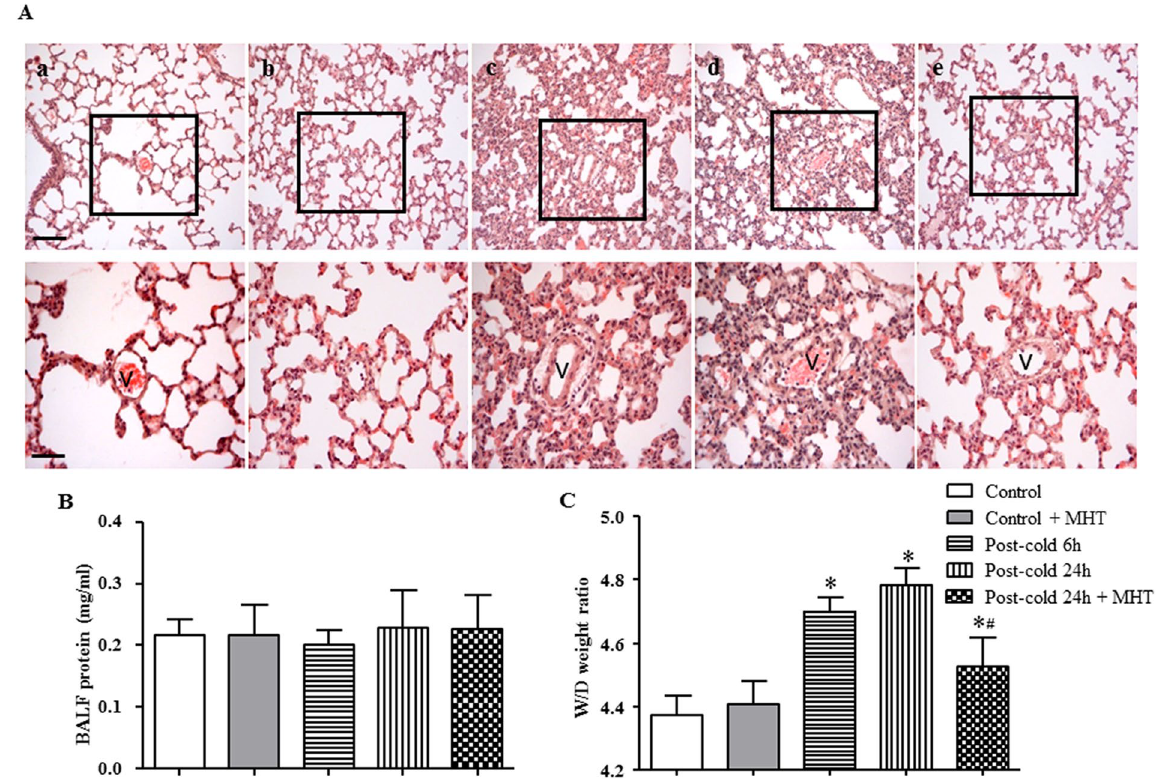
Figure 3. Effect of MHT post-treatment on histology of the lung tissue and lung edema. ( A ) Representative H&E staining images of rat lung tissue in Control (a), Control + MHT (b), Post-cold 6 h (c), Post-cold 24 h (d), Post-cold 24 h + MHT (e) group, respectively. Bar = 100 μ m. The area within the rectangle in each image in upper panel is enlarged and presented below. v, microvessel. Bar = 50 μ m. ( B ) BALF protein